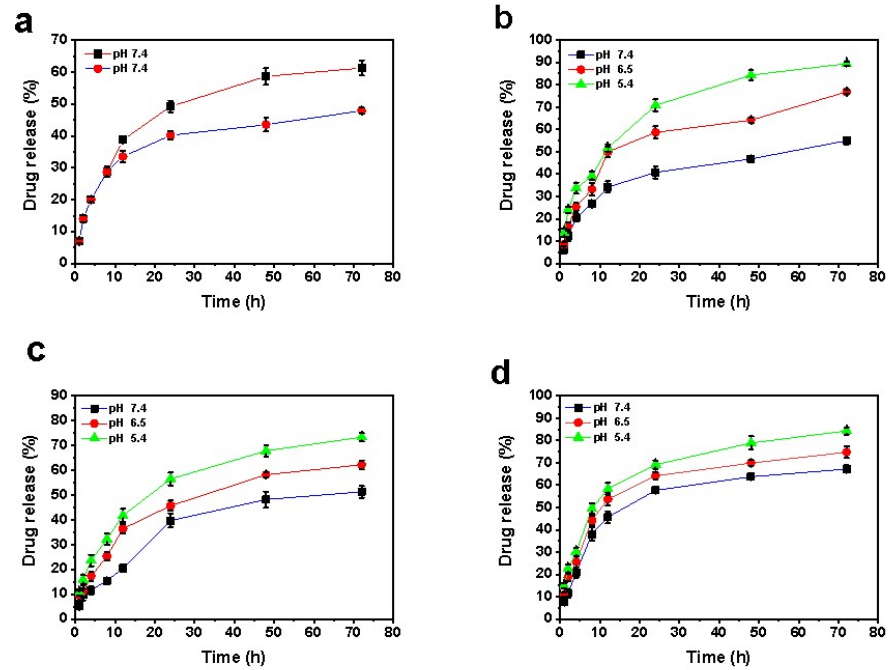
Figure 2. In vitro drug release profile of ( a ) letrozole from NiCoFe 2 O 4 @L-Silica (black square) and NiCoFe 2 O 4 @L-Silica@Ni- osome (red circle) at pH = 7.4; ( b ) letrozole from NiCoFe 2 O 4 @L-Silica@L-Niosome at different pH; ( c ) letrozole from Ni- CoFe 2 O 4 @L-Silica@C-Niosome at different pH, and ( d ) curcumin from NiCoFe 2 O 4 @L-Silica@C-Niosome at different